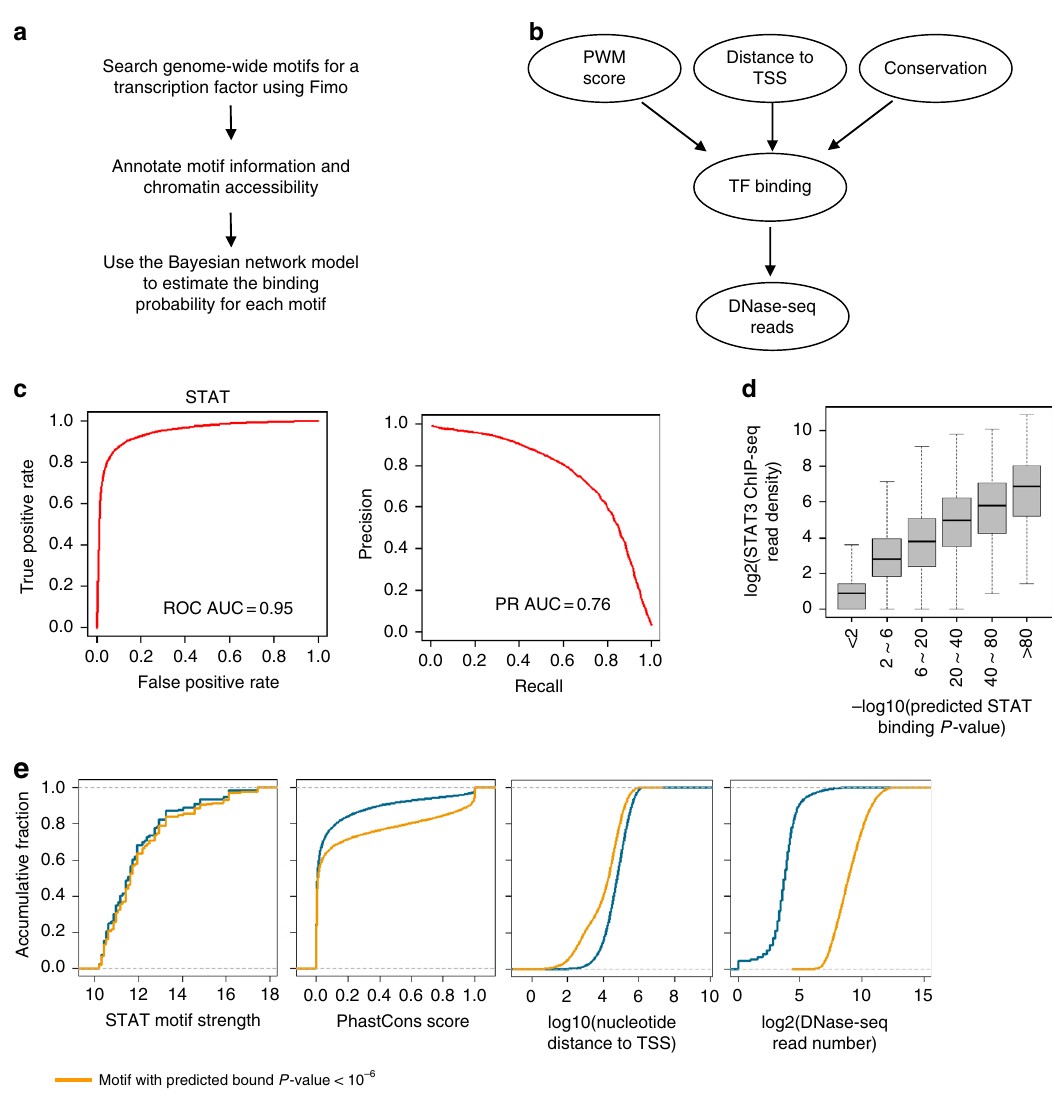
Fig. 3 AccessTF, a Bayesian network model to identify TF binding sites. a Steps of computational analyses for identifying transcription factor binding sites using DNase-seq data. b AccessTF integrates motif strength, distance to the closest transcription start site, Phastcon conservation score and surrounding DNase-seq reads. See Methods for a detailed description. c Area under ROC curves (ROC AUC) and Area under Precisions-Recall Curves (PR AUC) for measuring the performance of AccessTF predicting the STAT binding status. d STAT motifs grouped by predicted binding probabilities and plotted against STAT3 binding levels in 400 nt region around the motifs (estimated by ChIP-seq data) after transformation. For the box plot, the bounds of the box represent the fi rst and third quartiles and the center line represents the median. e Comparing features of STAT motifs with predicted bound P -value < 10 − 6 vs.